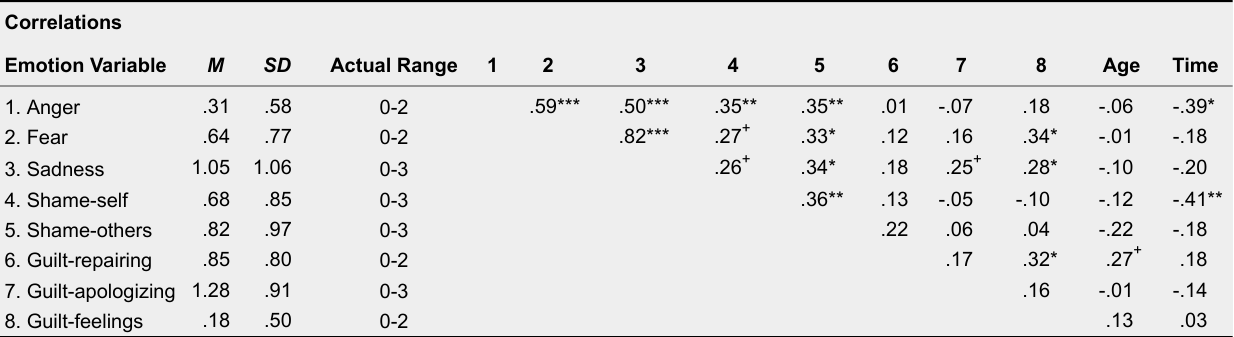
Descriptive Statistics for Emotion Variables and Correlations between Emotions and Child-Related Variables (N = 51)